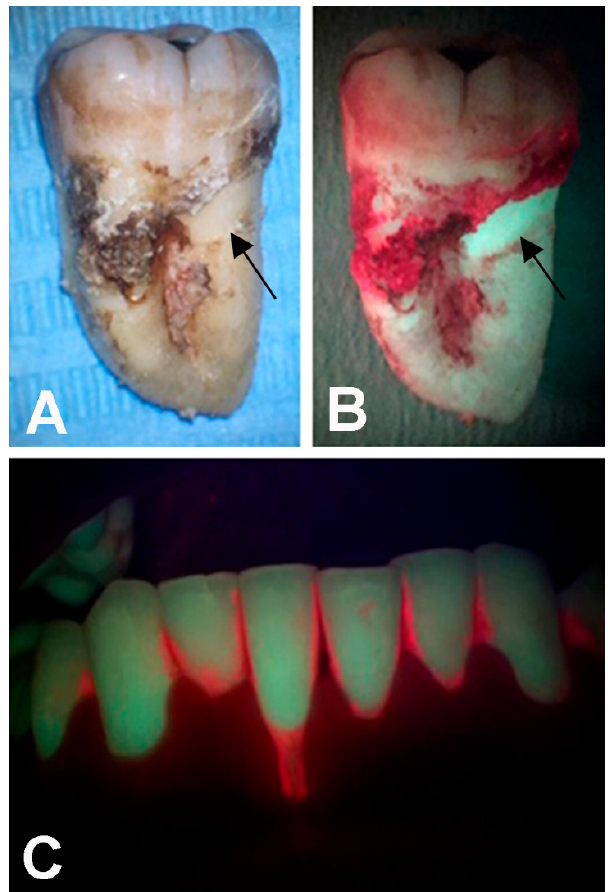
Figure 1. ( A , B ): Photoablation of dental calculus and plaque by Erbium-doped Yttrium-Aluminium garnet (Er:YAG) laser on an extracted root. Arrows point at the treated area. ( B ) Red fluorescence of the contaminated root surface revealed upon irradiation with λ 405nm blue light. ( C ) The same photodiagnostic approach is used to detect full-mouth dental plaque.